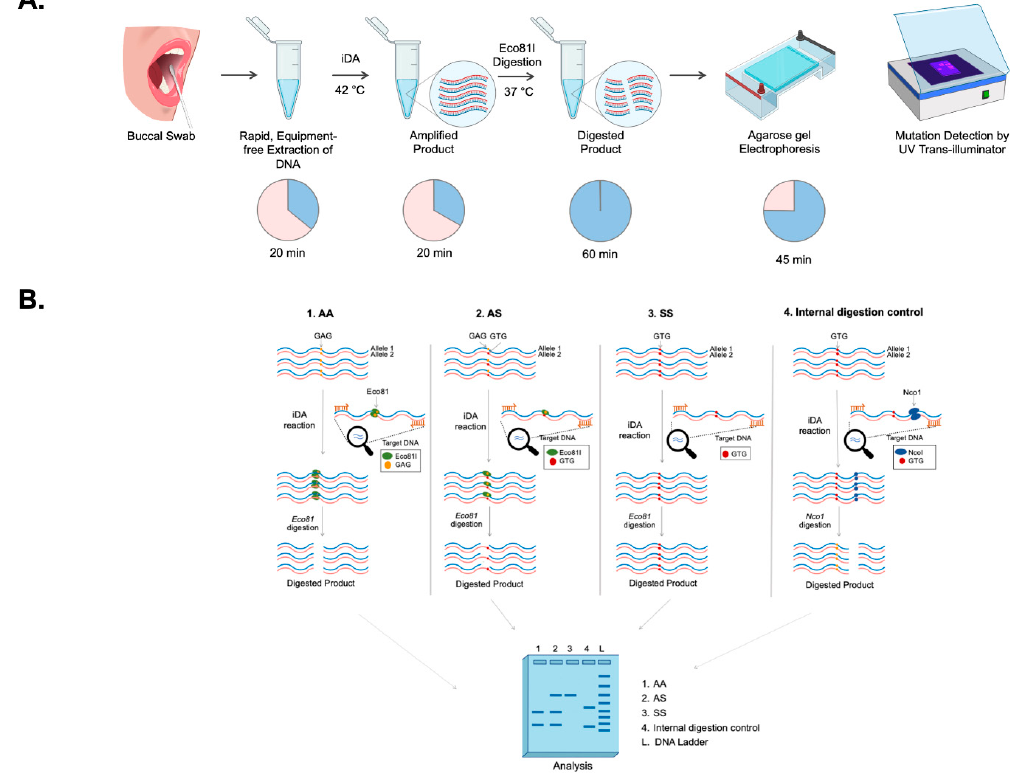
Figure 1. Experimental design of iDAR assay. ( A ) Schematics showing the workflow of iDAR. ( B ) Schematic showing the screening strategy for allele-specific sickle cell mutation detection using iDAR.